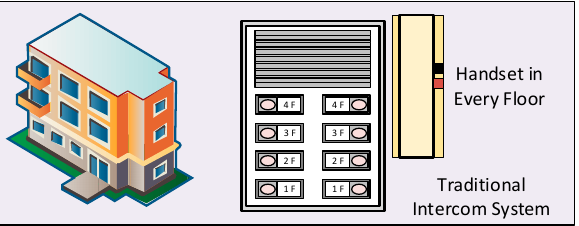
Figure 1. Schematic diagram of the traditional intercom system.